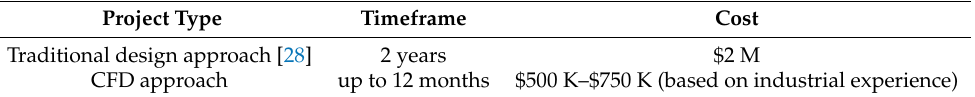
Table 19. Comparison of cost/benefit between CFD approach and OTSG traditional design